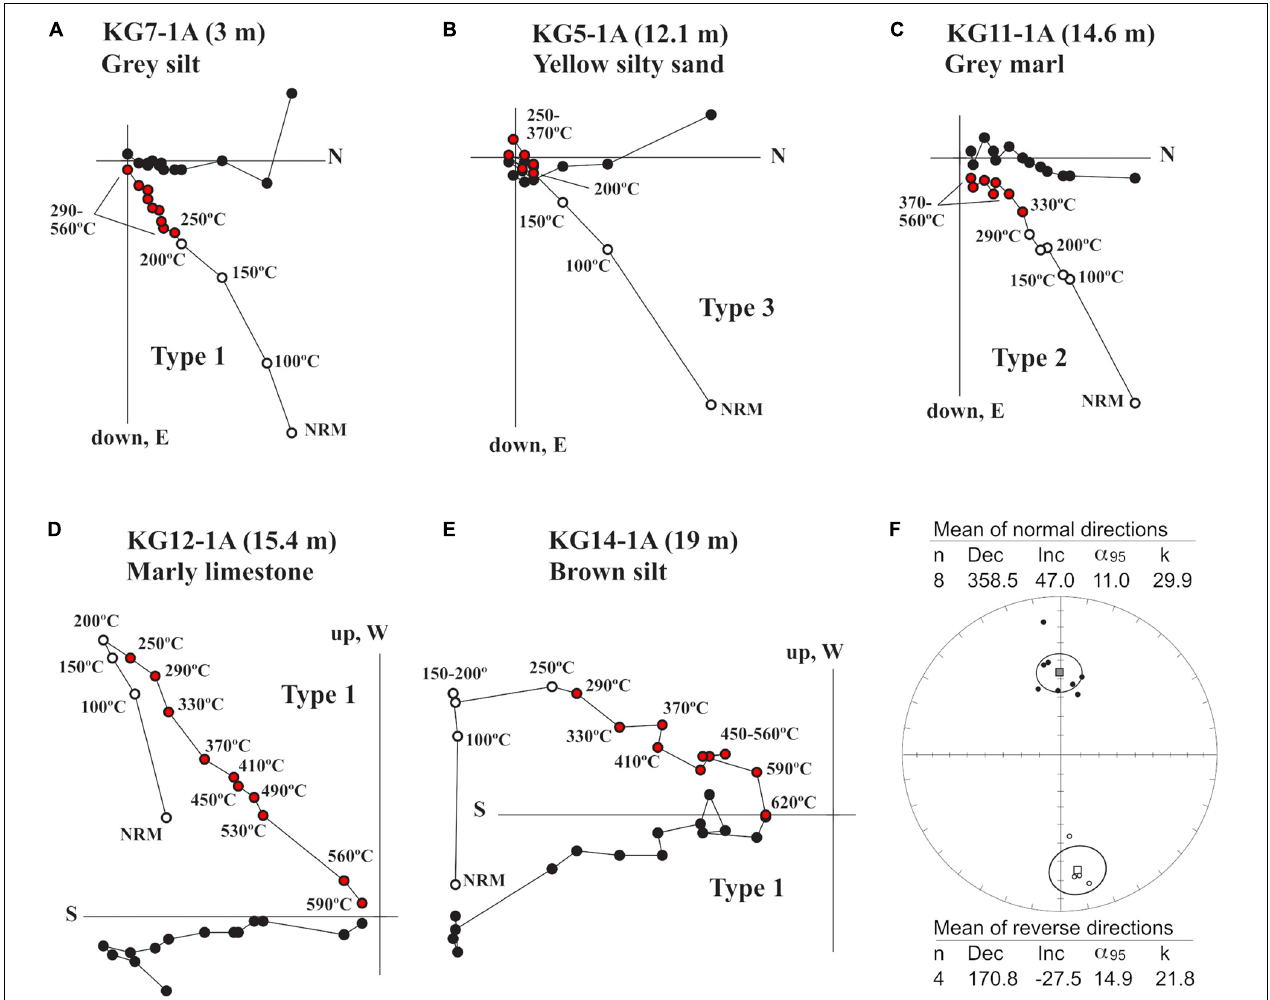
FIGURE 6 | Orthogonal demagnetization plots of samples representative for Type 1 (A,D,E) , Type 2 (C) and Type 3 (B) behaviors. Black and white dots represent projections in the horizontal and vertical planes, respectively. Red dots in the vertical projections indicate the temperature steps included in the calculation of the ChRM directions. (F) Equal-area stereonet projection of individual samples (circles), along with the mean directions and associated statistics of the normal and reverse polarity samples (squares). Bold (open) symbols represents projection in the lower (upper) hemisphere. Only types 1 and 2 samples have been considered for the